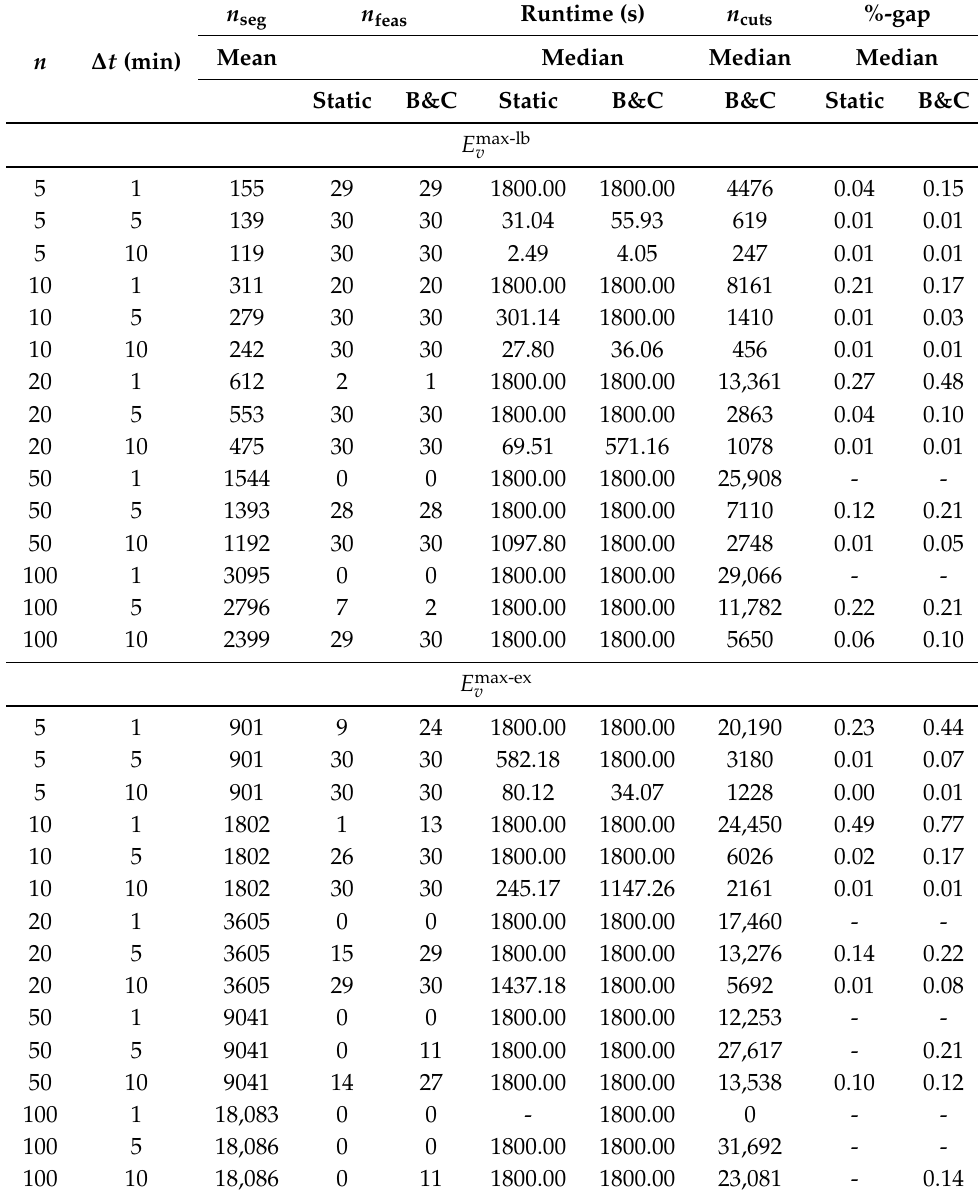
Table 5. EVS-SOC-GLIN results for solving the static model versus B&C with E max-lb v and E max-ex